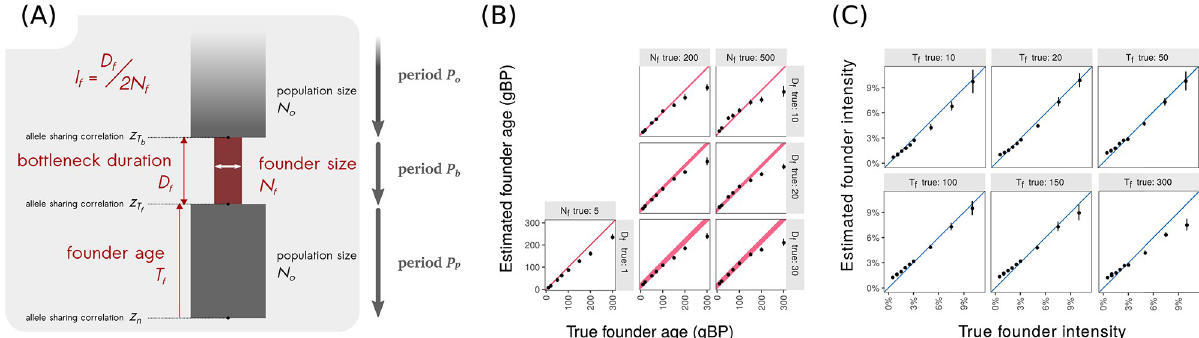
Fig 1. ASCEND simulation results. (A) Model of founder event . Consider a population which has experienced a founder event in its past. This history can be divided into three main periods (from the most ancient to the most recent): a period P o where the population has a constant effective population , followed by a period P where the effective population size reduces to N for the duration of D generations till T generations before present. size of N o b f f f Then, the population recovers and the population size returns to N o during the period P P . We simulated two populations, population A (target) which experienced a founder event and population O (outgroup, no founder event, with constant size N ) that diverged 1,800 generations ago. We ran o ASCEND and compared the estimated parameters with the true parameters of the founder event in population A . ( B) Accuracy in estimating founder age . The X -axis shows the true founder age that was simulated in generations before present (gBP) and the Y -axis shows the founder age estimated by ASCEND . The diagonal represents the expectation (i.e., the case where the estimated values are the same as the true values). We note that for D f > 0 we show a thick band for the diagonal, proportional to duration of the founder event. ( C) Accuracy in estimating founder intensity . We define the founder intensity as the ratio of the bottleneck duration over twice the effective population size during the bottleneck, i.e. I = D /(2 N ). The X -axis shows the true f f f founder intensity, and the Y -axis shows the estimated founder intensity. The diagonal represents the expectation (i.e., the case where the estimated values are the same as the true